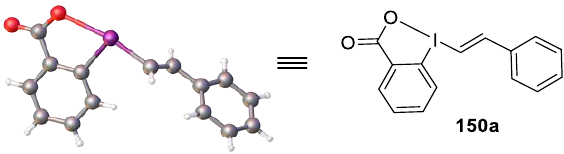
Figure 3. X-Ray structure of vinylbenziodoxole 150a [154].